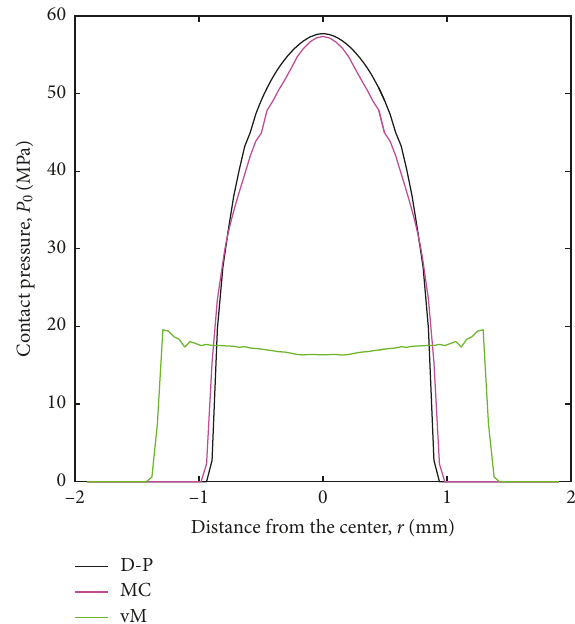
Figure 5: Distribution of normal pressure on the contact surface for F 100 N. (cid:31)